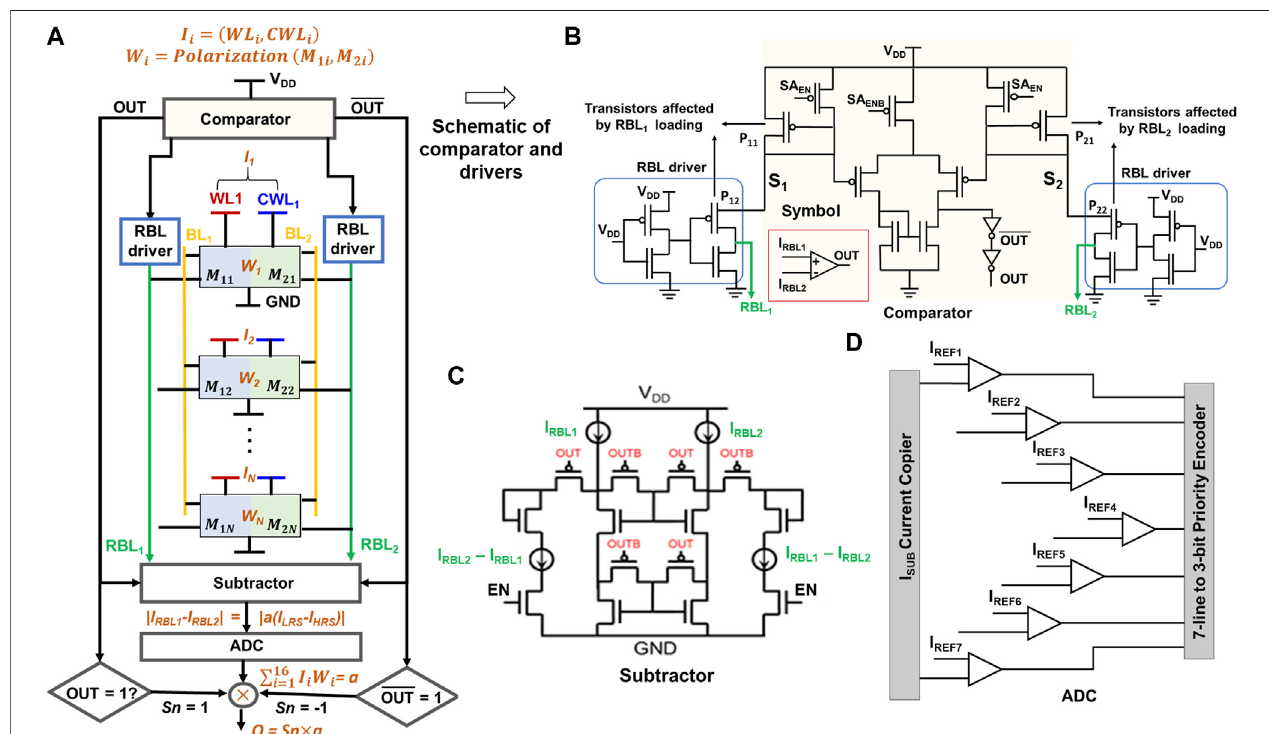
FIGURE9 |(A) Column ofthe STeP-CiMcell for MAC operation. In the schematic representation, we labeled weights ( W ) as combination ofpolarization in M 1i and M 2i conforming to encoding in Table 3A , while inputs of a cell are encoded utilizing WL and CWL , according to Table 3C . Peripherals used in the simulation of a MAC operation such as comparators, read drivers, subtractors, and ADC are shown. Schematic representation of (B) read drivers interacting with RBL and comparator. (C) Subtractor and (D) 3-bit ADC represented using symbol in inset of (B)